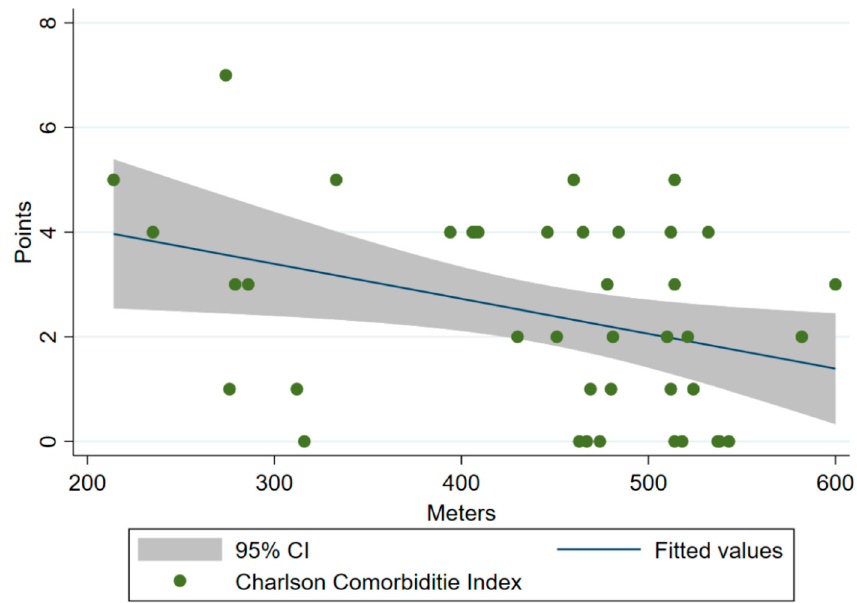
Figure 2. Scatter plot with regression line showing crude association between Charlson Comorbidity Index and distance covered (meters) in the 6MWT test one year after COVID-19 hospitalization.